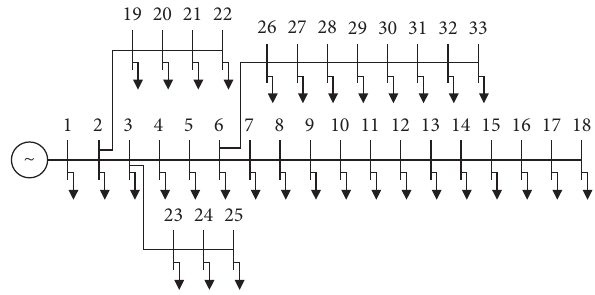
Figure 2: The 33-bus distribution